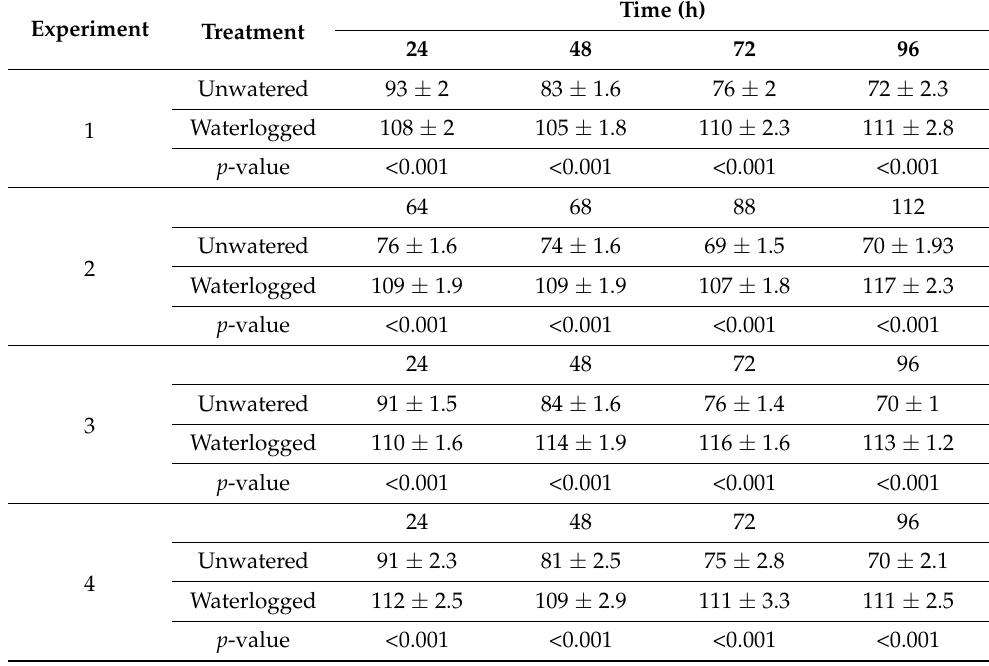
Table 1. Relative weight (%) of unwatered and waterlogged pots compared with the control over time for 4 experiments carried out on A. chinensis var chinensis ‘Zesy002’ (Experiments 1–3) and Actinidia chinensis var deliciosa ‘Hayward’ (Experiment 4) clonal kiwifruit plants. Probabilities ( p -values) from ANOVA refer to within-experiment comparisons.